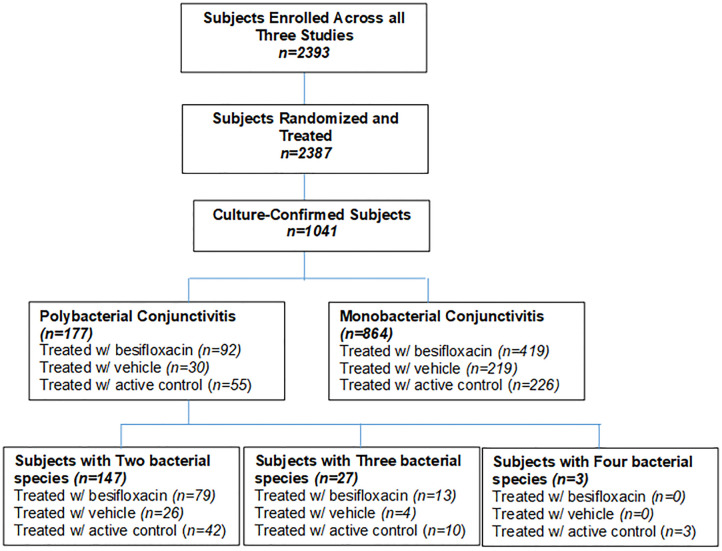
Distribution of subjects.